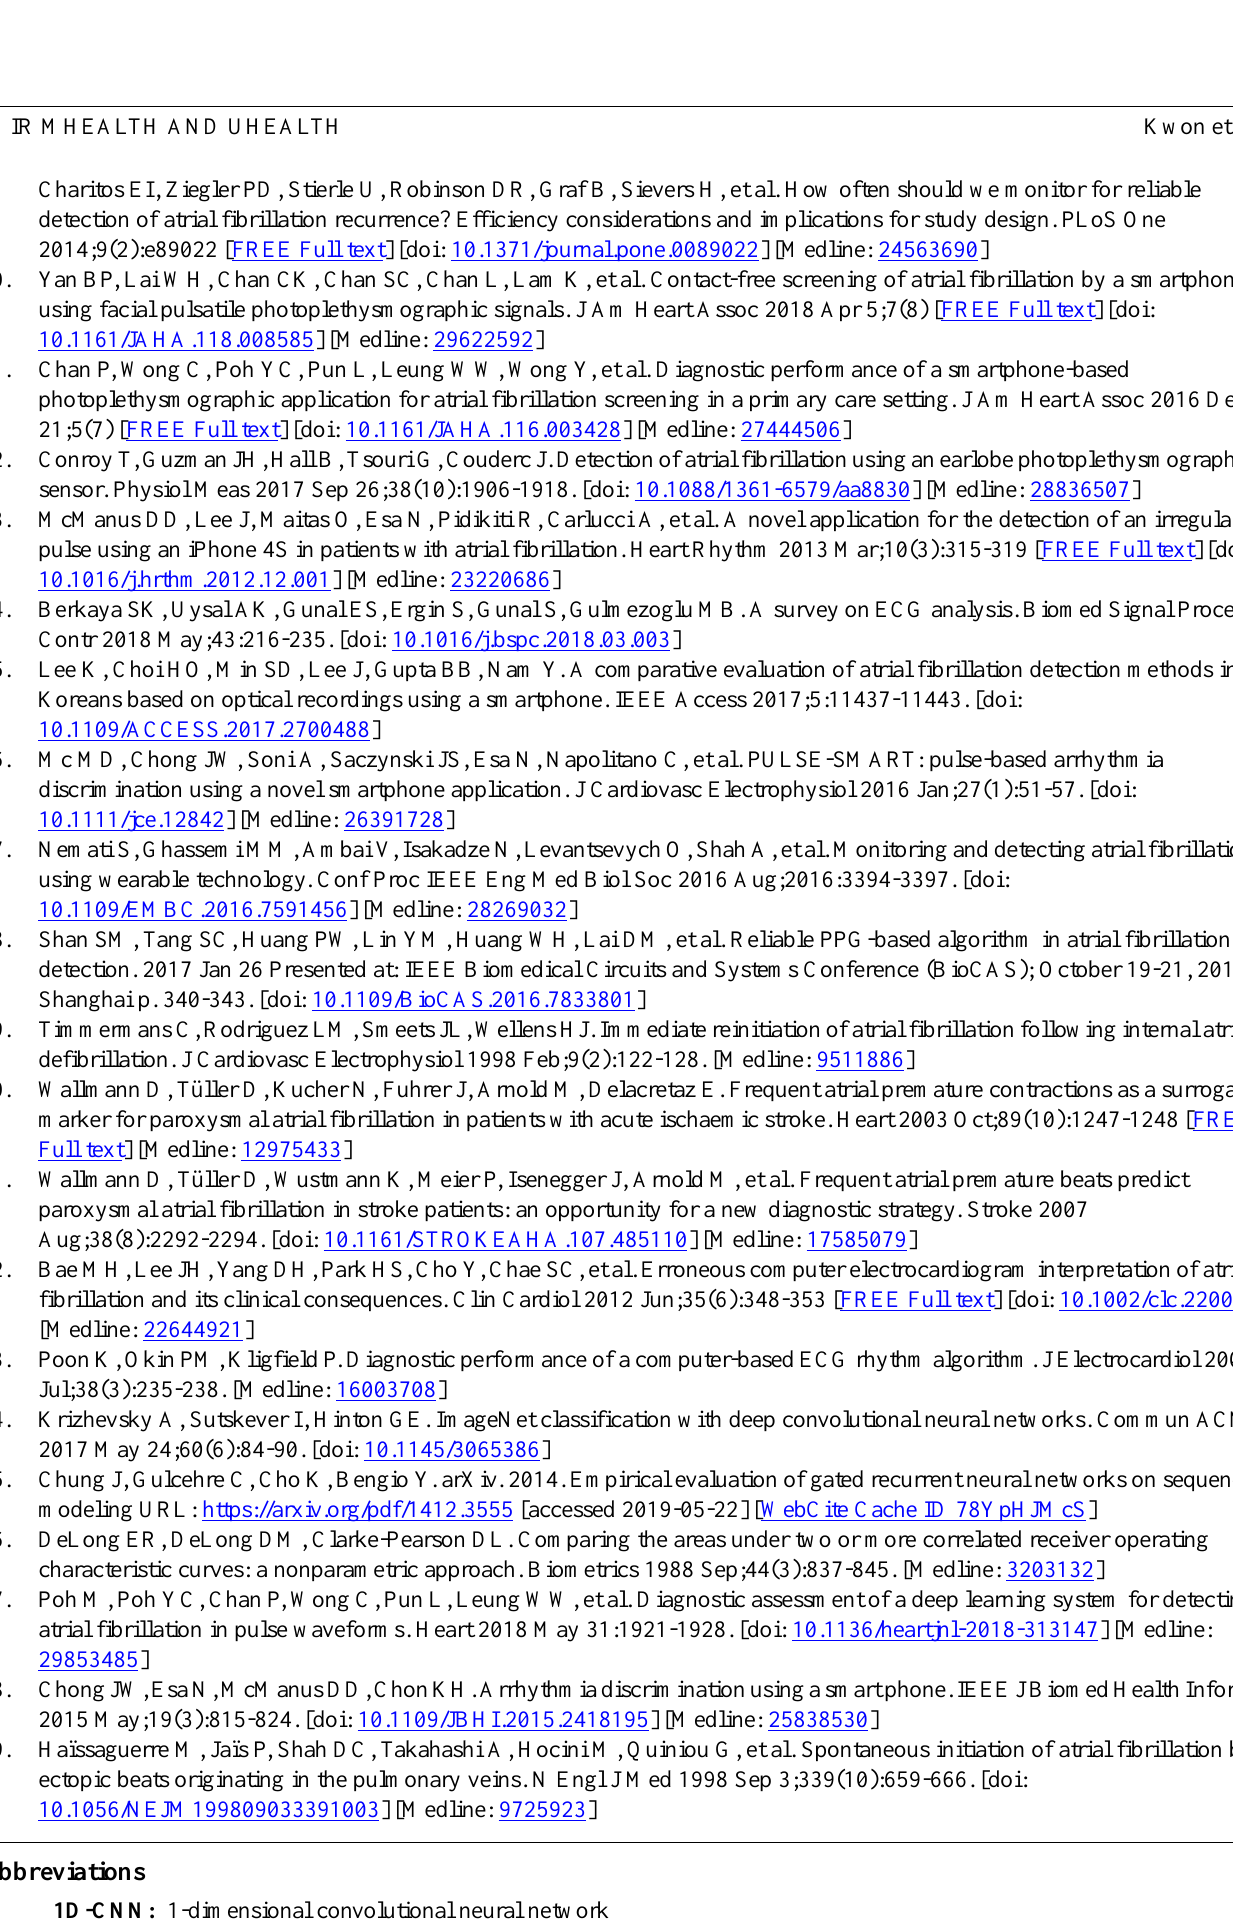
1D-CNN: 1-dimensional convolutional neural